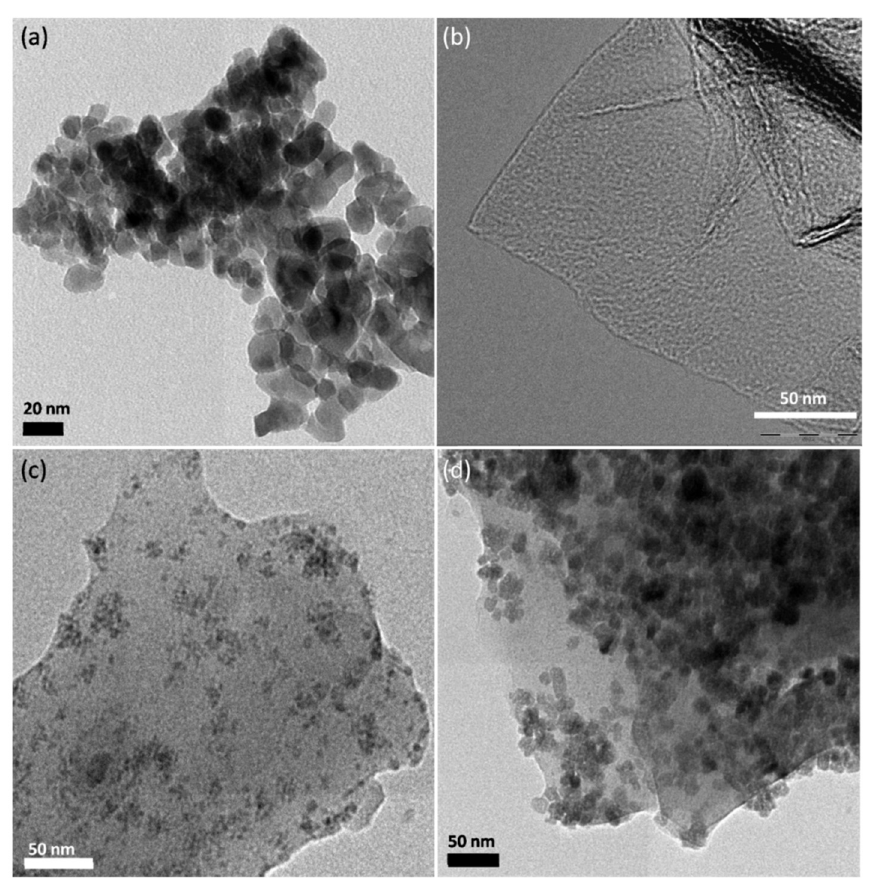
Figure 4. HR-TEM images of ( a ) HfO 2 nanoparticles, ( b ) graphene, ( c ) HfO 2 —graphene (10 wt%)